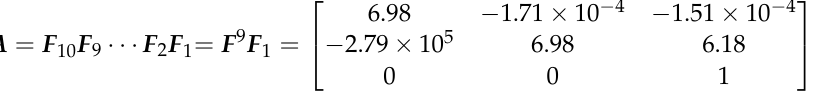
Table 1. The values of state vectors.